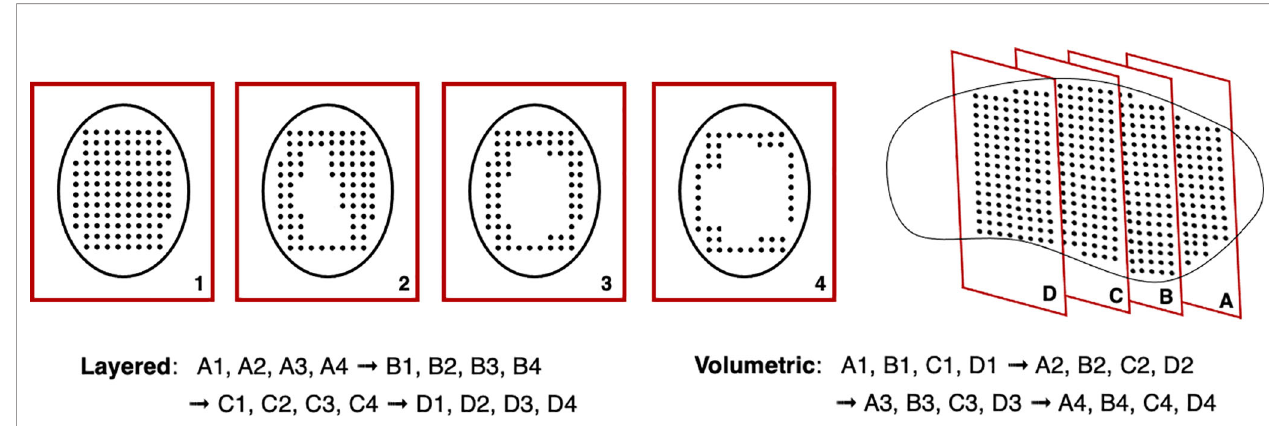
FIGURE 11 | Possible example IES pattern sequences for layered and volumetric